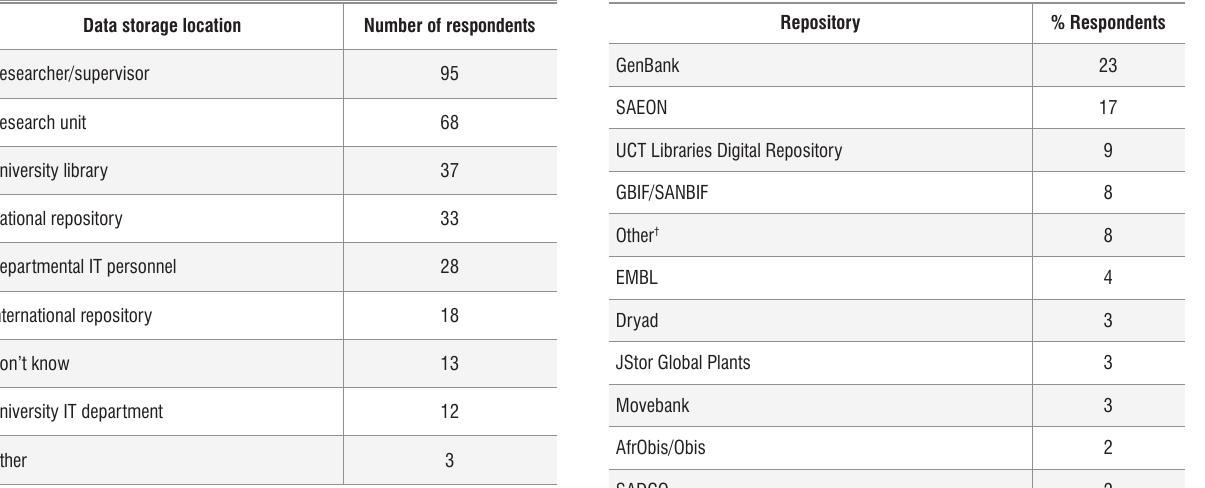
The number of respondents who attributed responsibility for storage of data sets to each possible response